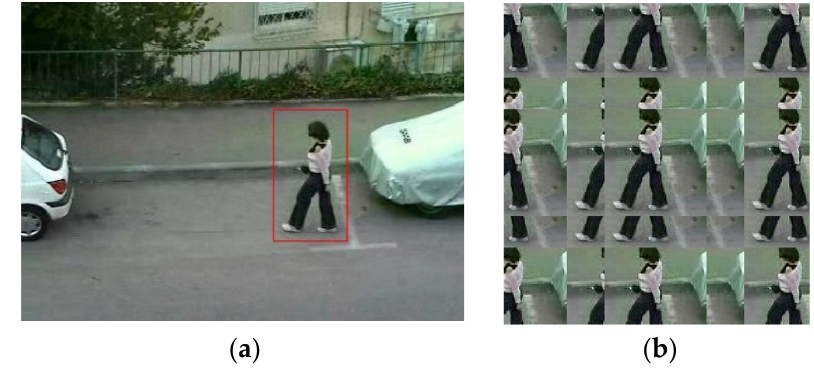
Figure 4. Circular shift: ( a ) original image; ( b ) periodicity in shift samples.